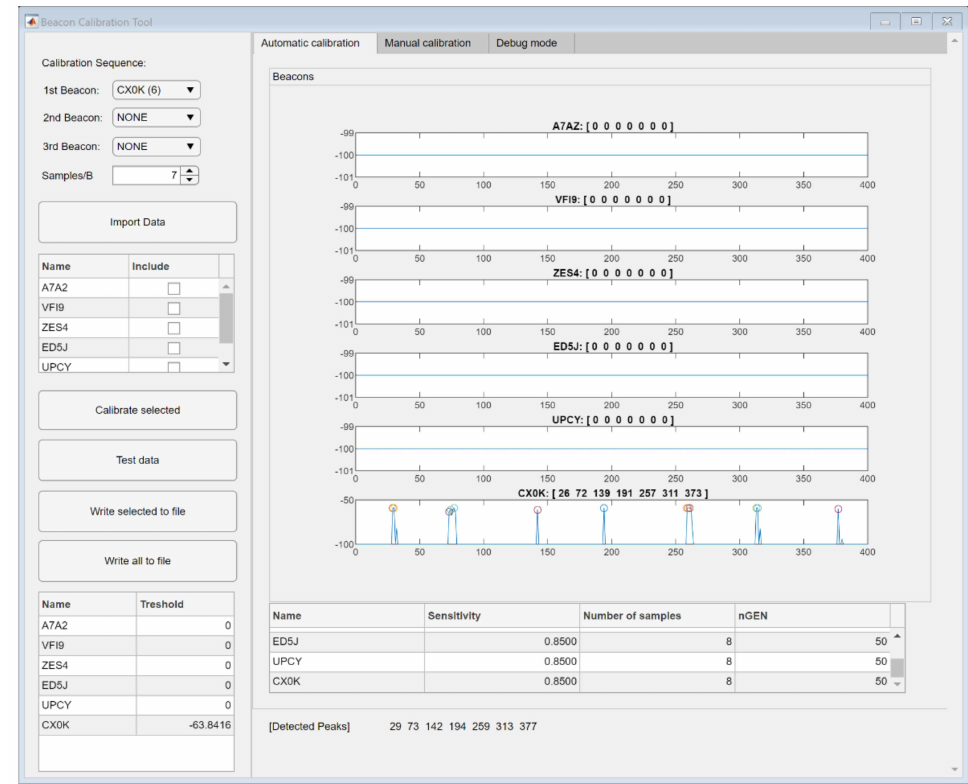
Figure 5. Beacon calibration tool, developed in